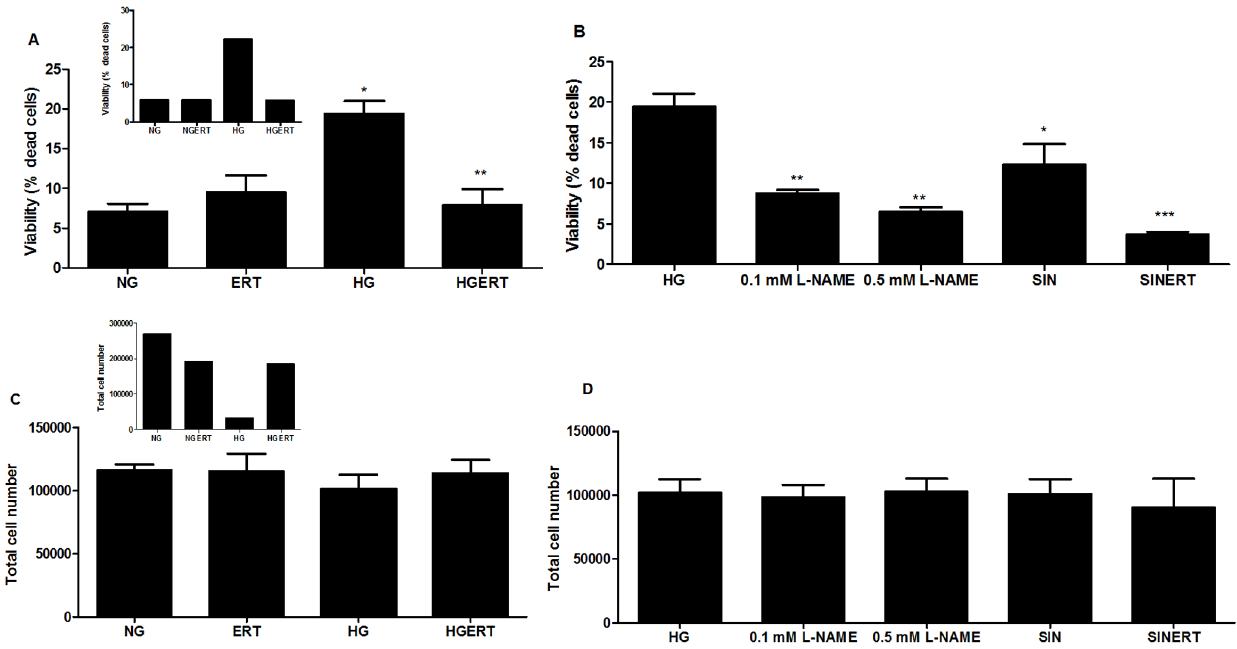
Figure 1. Erythritol attenuates cell death induced by diabetic stressors. Effect on viability of HUVECs incubated with normal glucose (NG, 7 mM) or high glucose (HG, 30 mM) in the presence or absence of erythritol (ERT, 5 mM) for 24 hours (A). Effect on viability of HUVECs incubated with HG in the presence N G -nitro-L-arginine methyl ester (L-NAME, 0.1 mM and 0.5 mM) and 3-morpholino sidnonimine (SIN, 0.5 mM) in the presence or absence of ERT (B) Effect of incubations on total cell number after 24 hours (C and D). Inset show data of 48 hour incubation with ERT, HG or HGERT (n=1). Data are expressed as means 6 standard error of at least three independent experiments. *=p , 0.05 compared to NG; **=p , 0.05 compared to HG; ***=p , 0.1 compared to SIN.